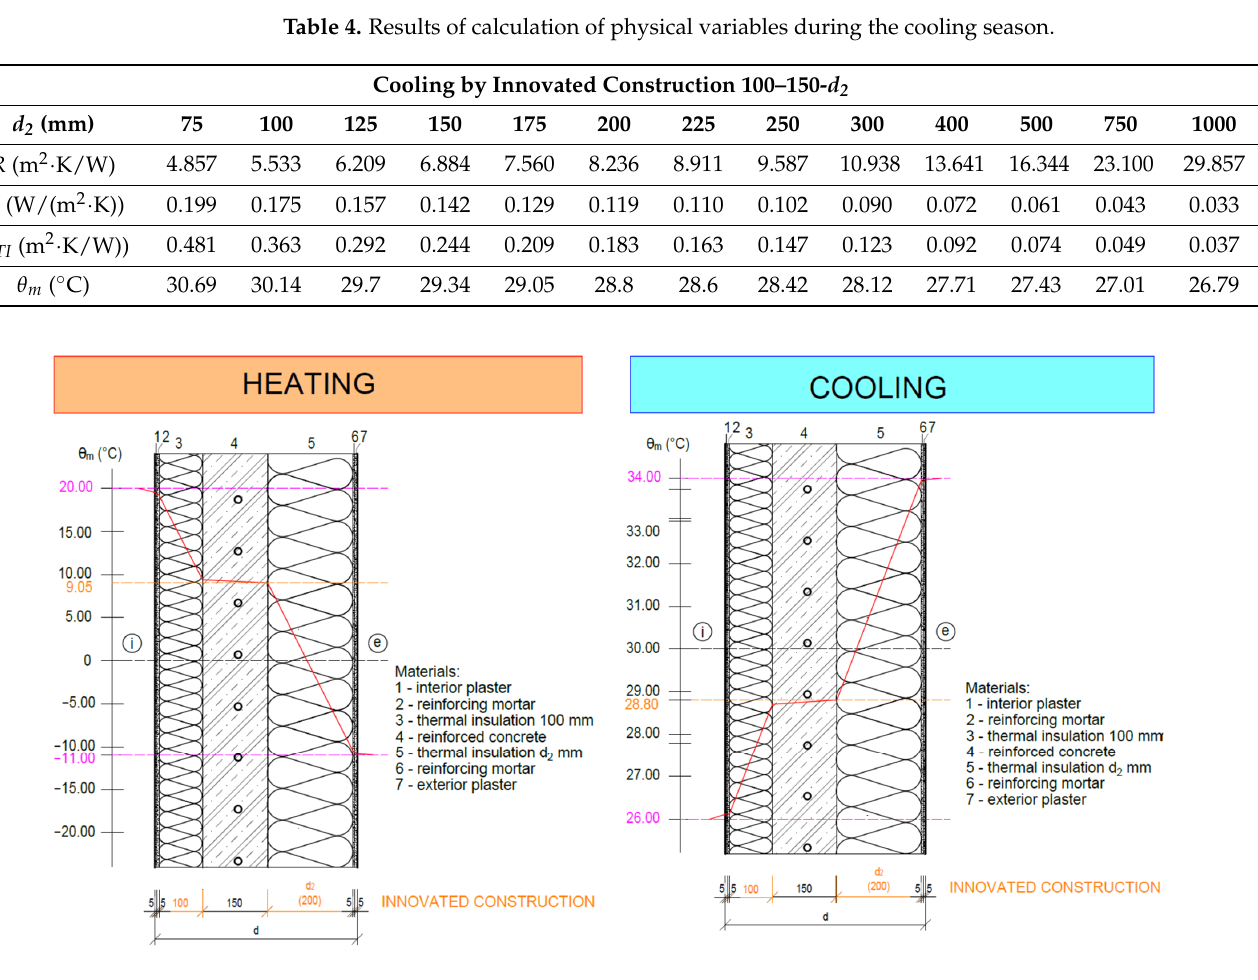
Figure 8. Temperatures in individual layers of the upgraded panel, i — interior, e — exterior.